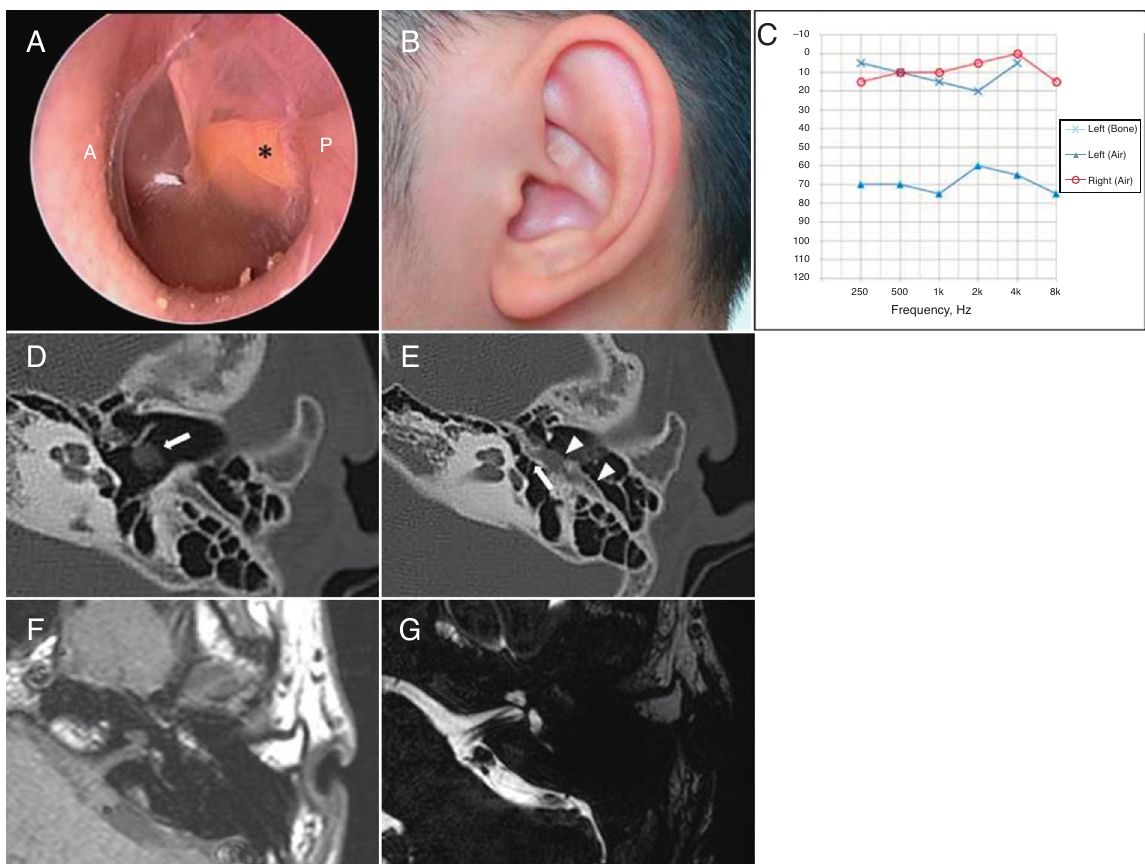
(A) Otoscopic examination reveals streak-like structure (asterisk) behind the eardrum. Yellowish bundle-like structure is placed at postero-superior quadrant. P, posterior canal wall; A, anterior canal wall. (B) External ear shows normal structure without anomaly. (C) Pure tone audiometry shows conductive hearing loss; air-bone conduction gap of 58 dB in the left ear. (D) Facial nerve dehiscence of tympanic segment, which is seen behind the tympanic membrane (white arrow). (E) Incudostapedial dislocation (white arrow) with lateralized facial nerve (white arrow head). (F) Intermediate signal intensity of the aberrant